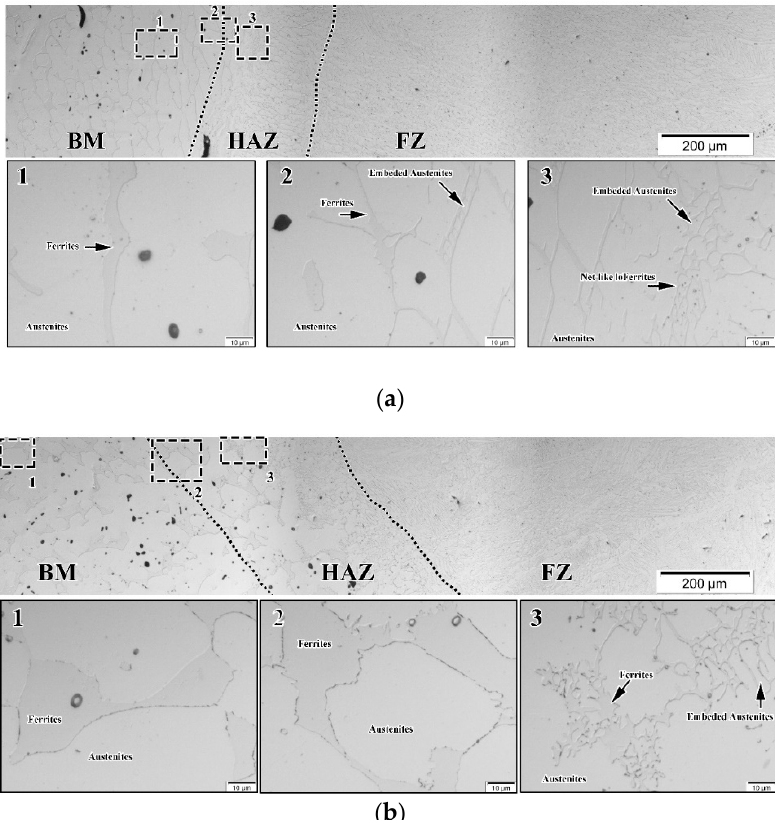
Figure 4. The temperature profiles by the bead-on-plate tests: ( a ) the HAZ, and ( b ) the weld.